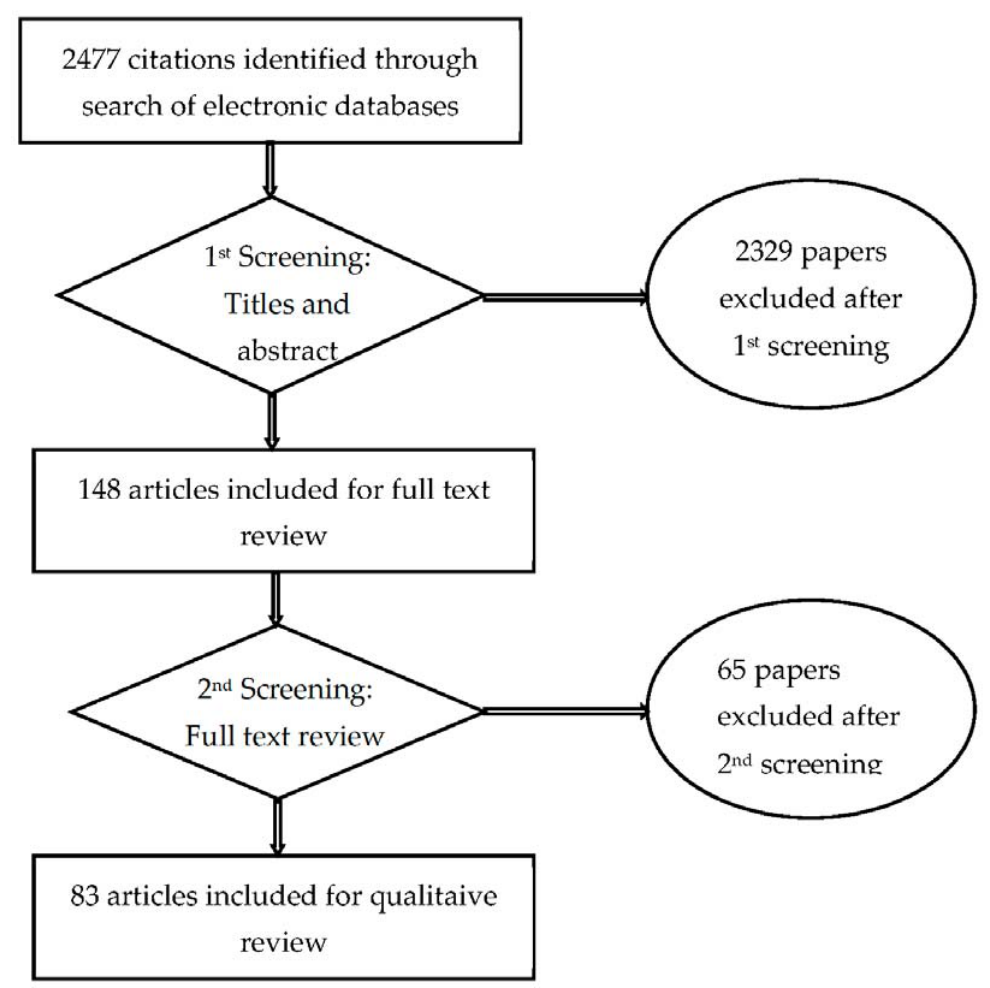
Figure 1. Flow chart for quantitative search and screening.